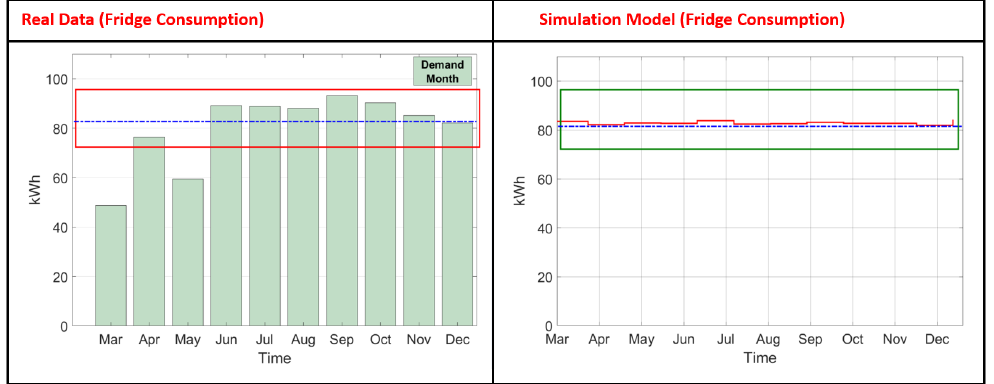
Figure 13. Real data vs. Simulation model (Fridge).